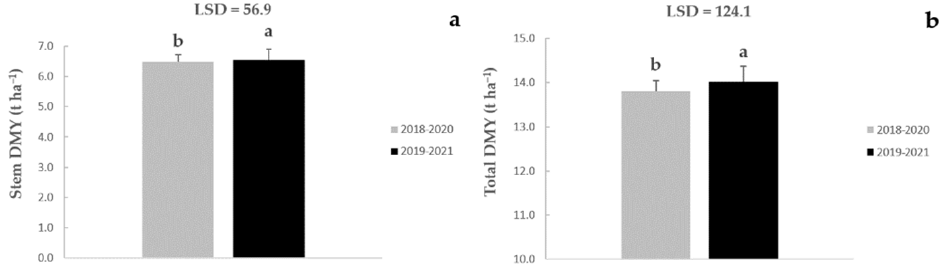
Figure 4. Sulla cumulative two-year ( a ) stem DMY (t ha − 1 ) and ( b ) total DMY (t ha − 1 ). Data refer to the first evaluation of sulla DMY (Eval 1). Different lowercase letters indicate significant differences. Vertical bars indicate standard errors. DMY; Dry Matter Yield.